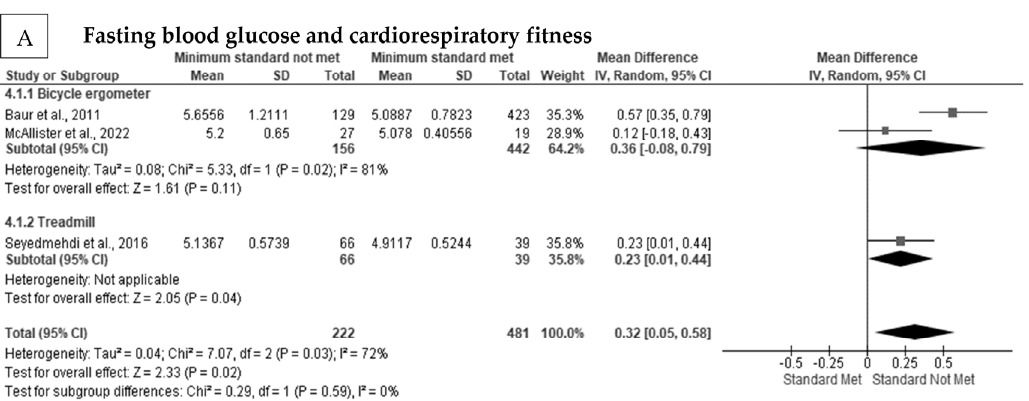
Figure 6. The association between cardiorespiratory fitness and blood glucose in firefighters: ( A ) The association between cardiorespiratory fitness and blood glucose concentration [30,69,79].